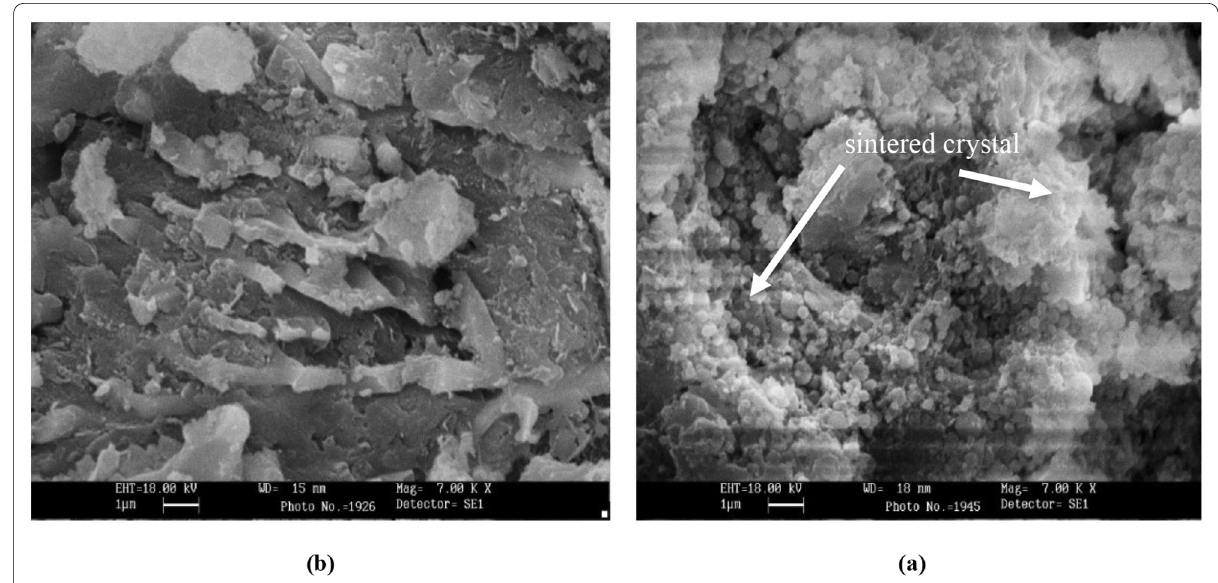
Fig. 18 SEM Images of HAC concrete a with GW and b without GW after heating